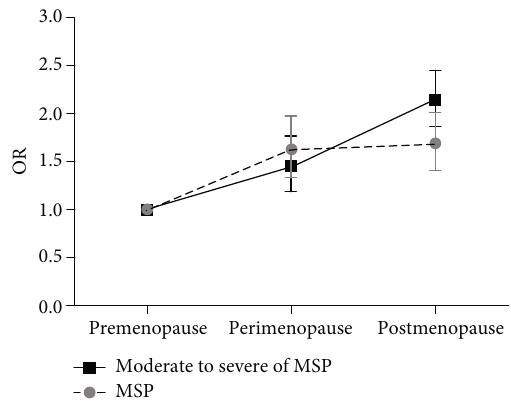
Figure 7: Calculated ORs for MSP degrees among di ff erent menopausal women. Premenopause OR is set as reference OR 1.00